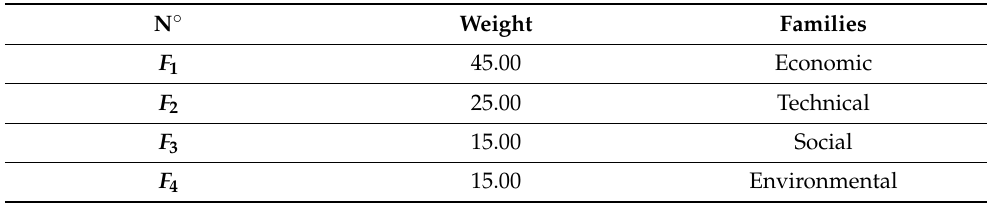
Table 5. Weighting of the criteria families.